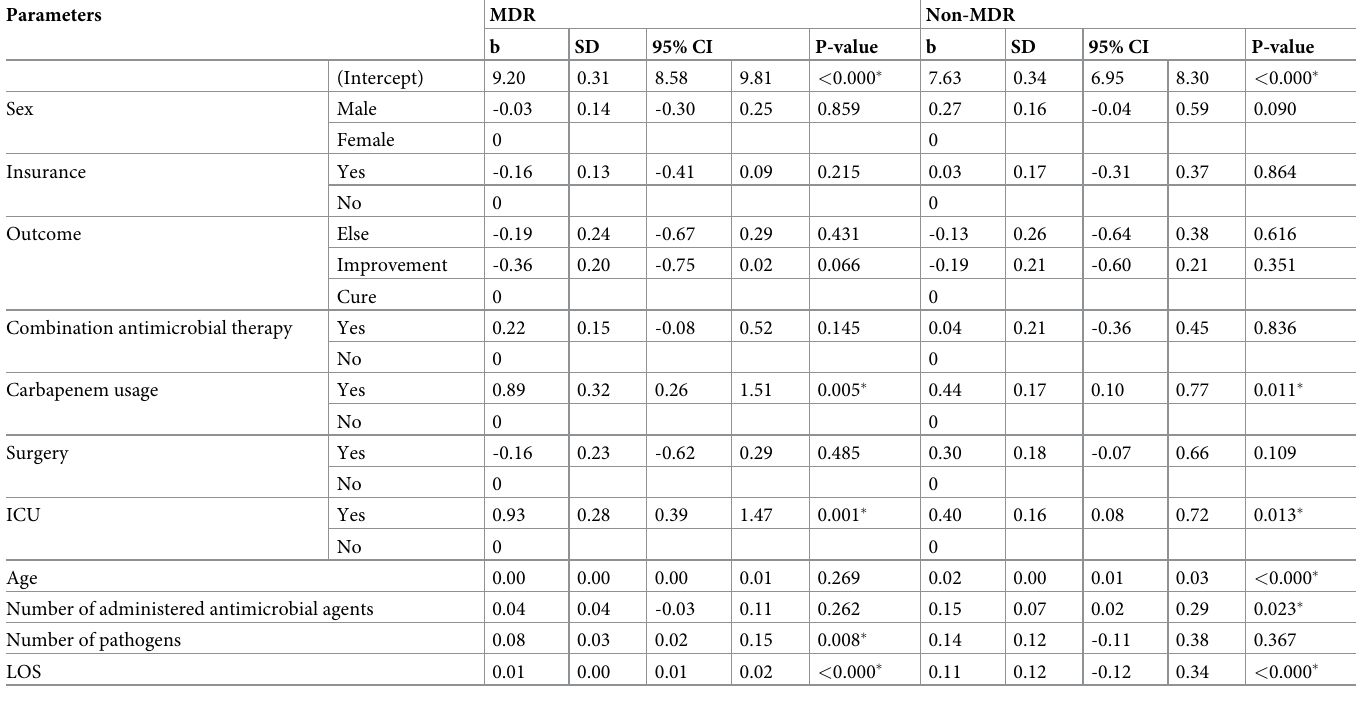
Table 3. Factors influencing total medical